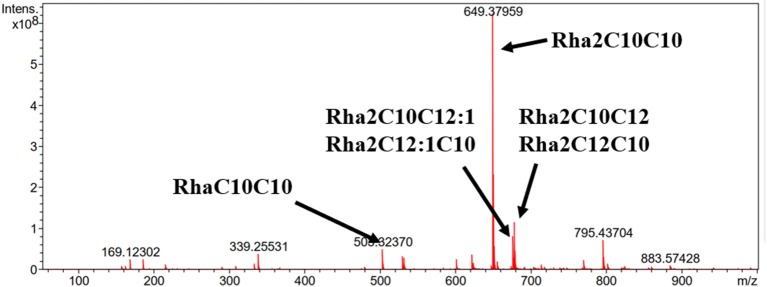
ESI-MS analysis of the produced rhamnolipids.